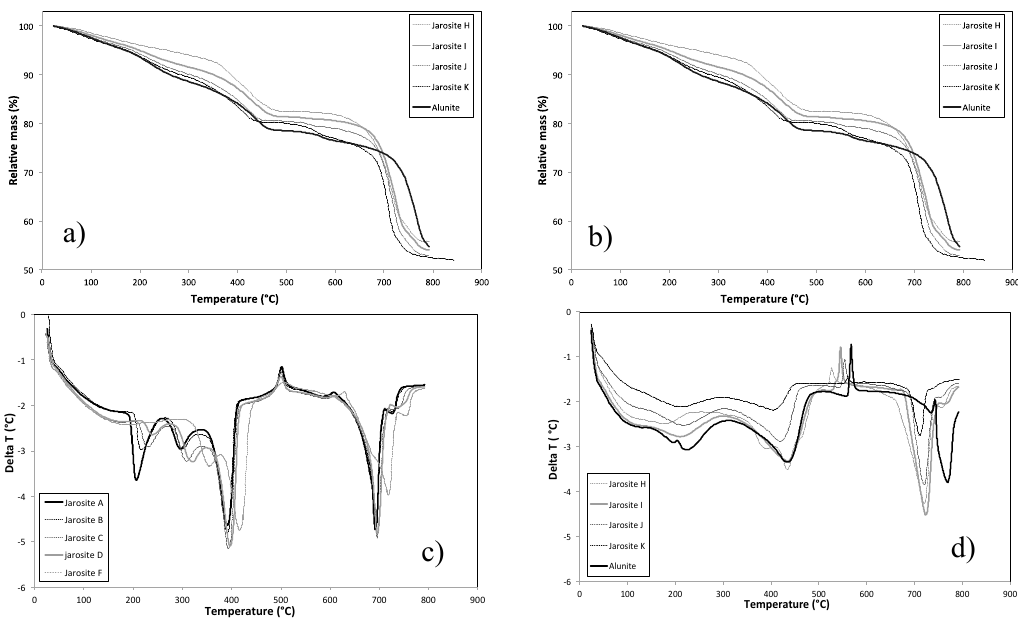
Figure 13. TGA results of mass loss (Relative mass, %) versus temperature (°C) ( a , c ) and DTA results, Delta T in °C ( b , d ) for addition of up to 0.9 Al mole fraction ( a , b ) and 0.9–1.0 mole fraction Al ( c , d ).